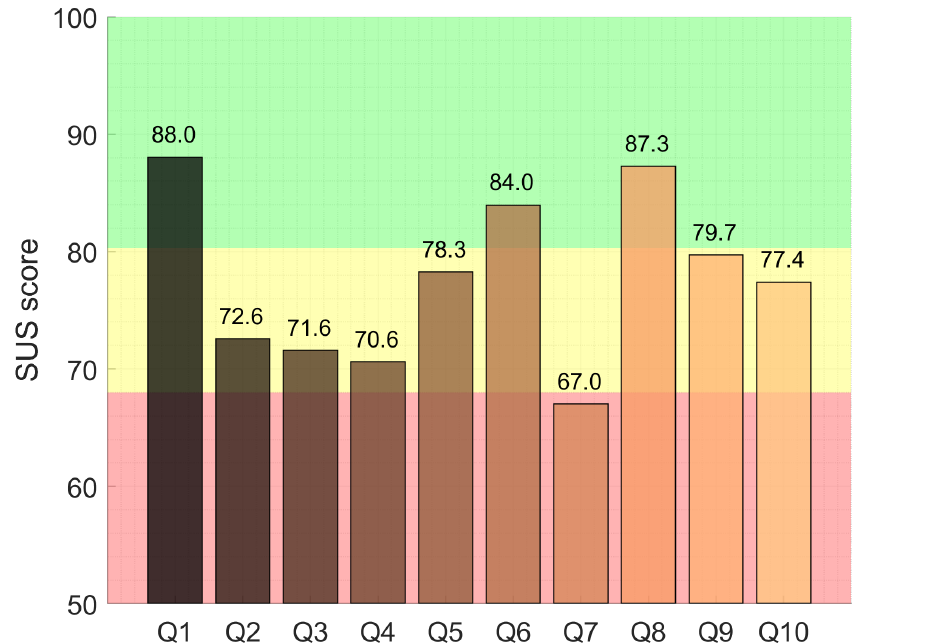
Figure 10. Results of System Usability Scale (SUS): Red—poor, yellow—good, green—excellent